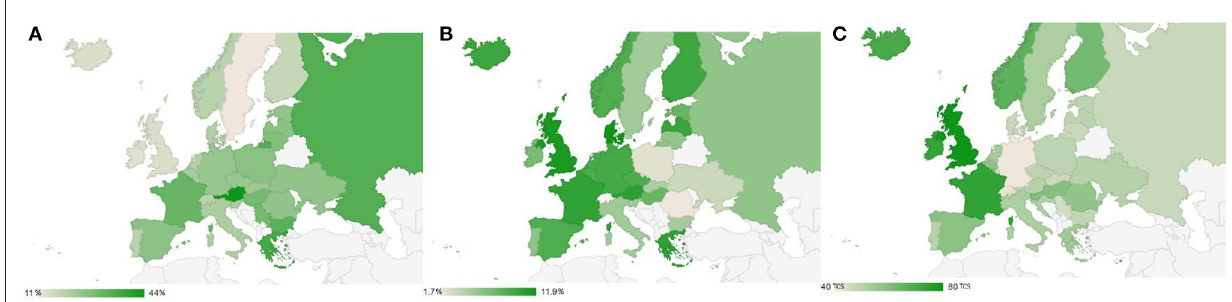
FIGURE1 The geographical pattern of cigarette smoking (A) , poly-product use (B) , and tobacco control scale score (C) in Europe. (A, B) Prevalence in %. (C) The Tobacco Control Scale (TCS) score of total maximum 100 (4). Data source: (A) WHO report on the global tobacco epidemic, 2013 (5). (B) Chen et al. (7). (C) The Tobacco Control Scale 2019 in Europe (4). (A, B) Reported prevalence data between 2010 and 2012 for comparability purposes. (C) Reported latest TCS score available in 2019 to reflect tobacco control status in Europe, most recent policy improvements may not yet be